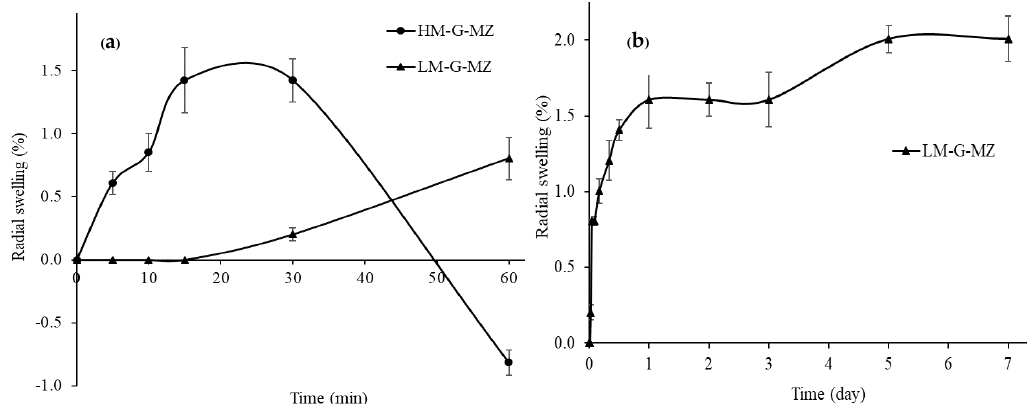
Figure 2. The swelling behavior of LM-G-MZ and HM-G-MZ films ( n = 6) on agar plate by diameter method at different time intervals from 0 to 1 h for both films ( a ) and up to seven days ( b ) for LM-G-MZ film.